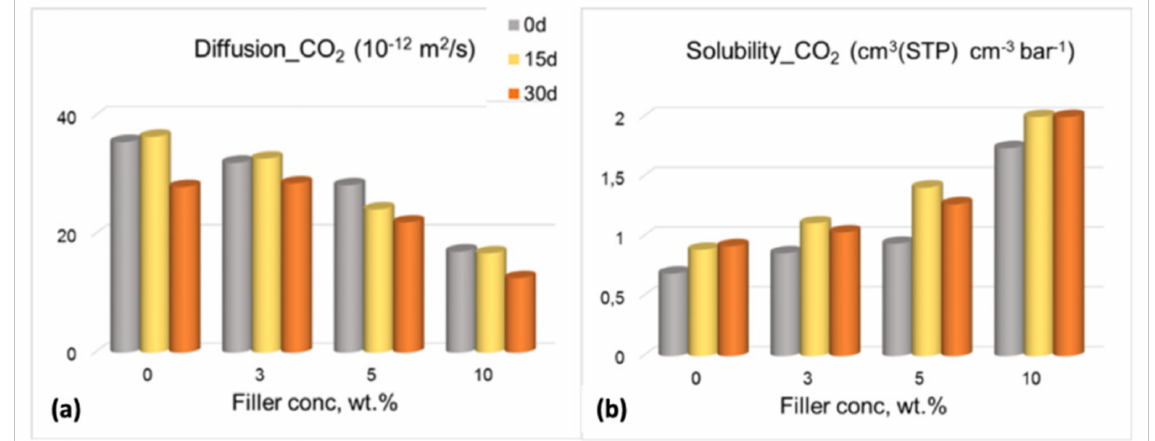
Figure 8. CO 2 diffusion ( a ) and solubility ( b ) coefficients for the films based on EVA with increasing loadings of LDH-MA. Film conditions: “as-prepared” (0 days) and photo-exposed (15 and 30